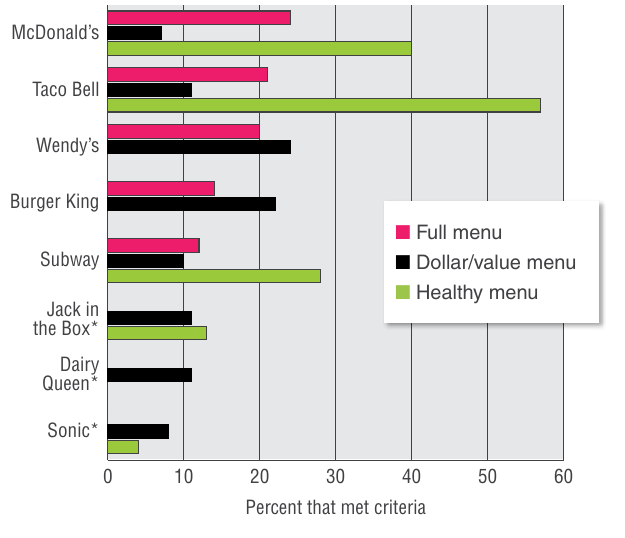
Figure 5. Percent of items that met all nutrition criteria from full menus and special